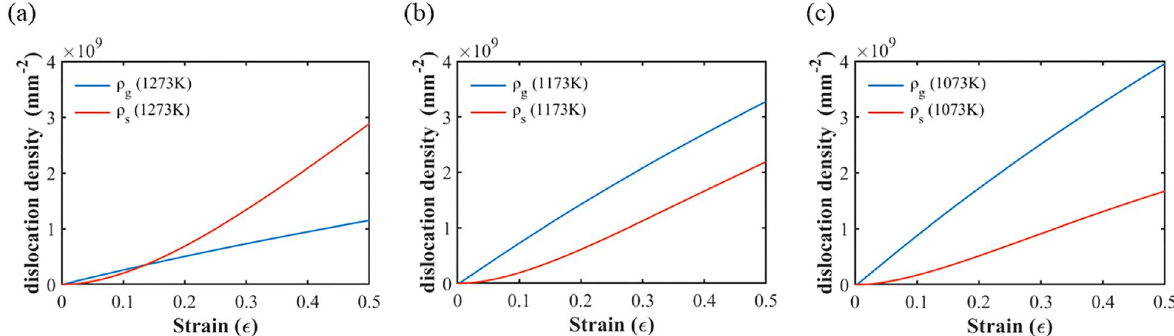
Figure 4. Evolution curves of the dislocation density for three annealing temperatures: ( a ) 1273 K, ( b ) 1173 K, and ( c ) 1073